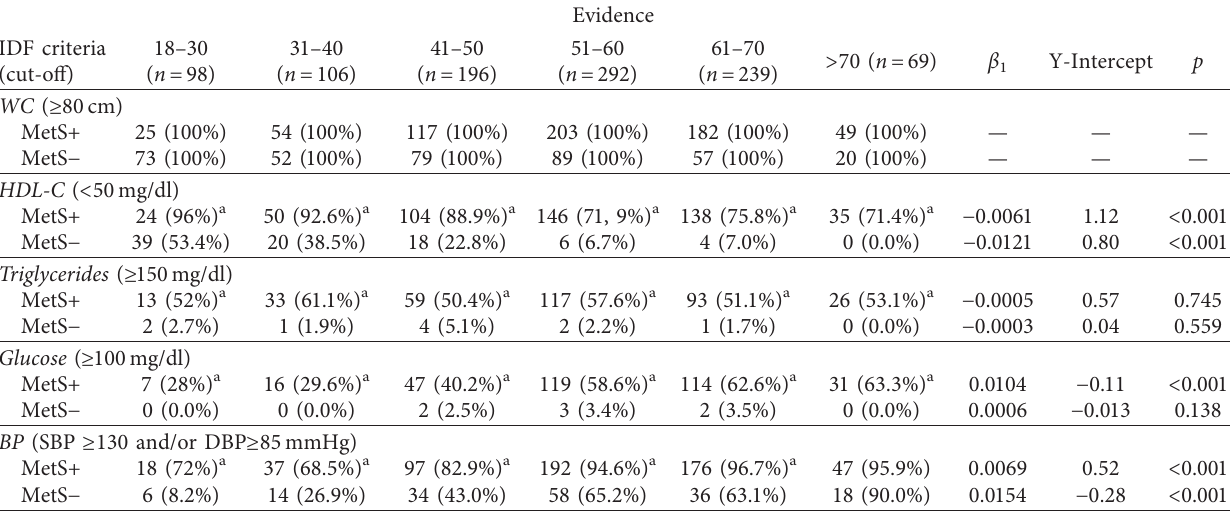
Table 3: Obese patients with or without metabolic syndrome, subdivided among age ranges, having altered IDF criteria.